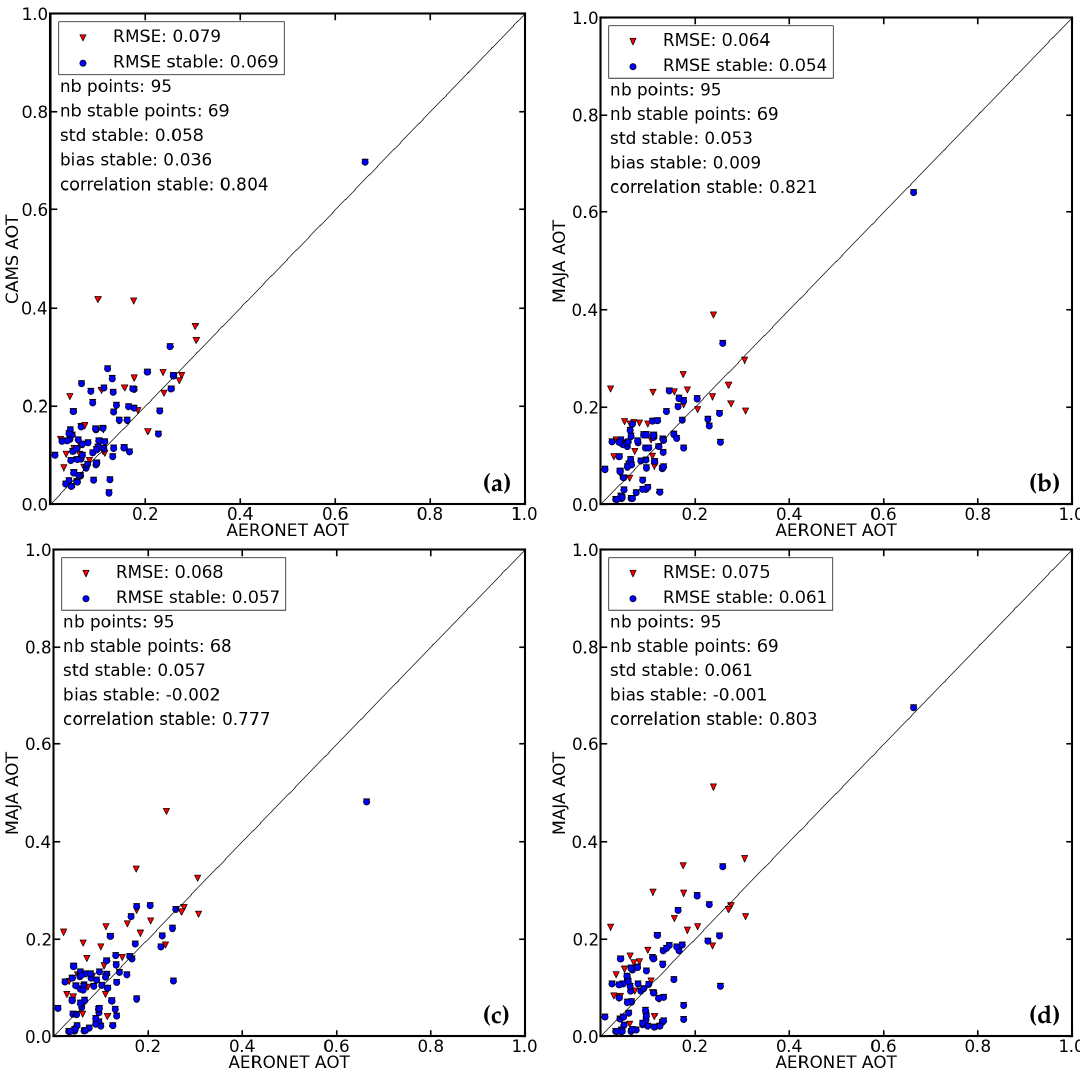
Figure 4. Scatter plots of aerosol optical thickness (AOT) at 550 nm versus AERONET (Aerosol Robotic Network) observations over vegetated sites: ( a ) AOT predicted by CAMS (Copernicus Atmosphere Monitoring Service); ( b ) AOT estimated by the MACCS-ATCOR Joint Algorithm (MAJA) with a constant aerosol type; ( c ) AOT estimated by MAJA using four CAMS aerosol types; and ( d ) AOT estimated by MAJA using five CAMS aerosol types. RMSE: root-mean-square error. std: standard